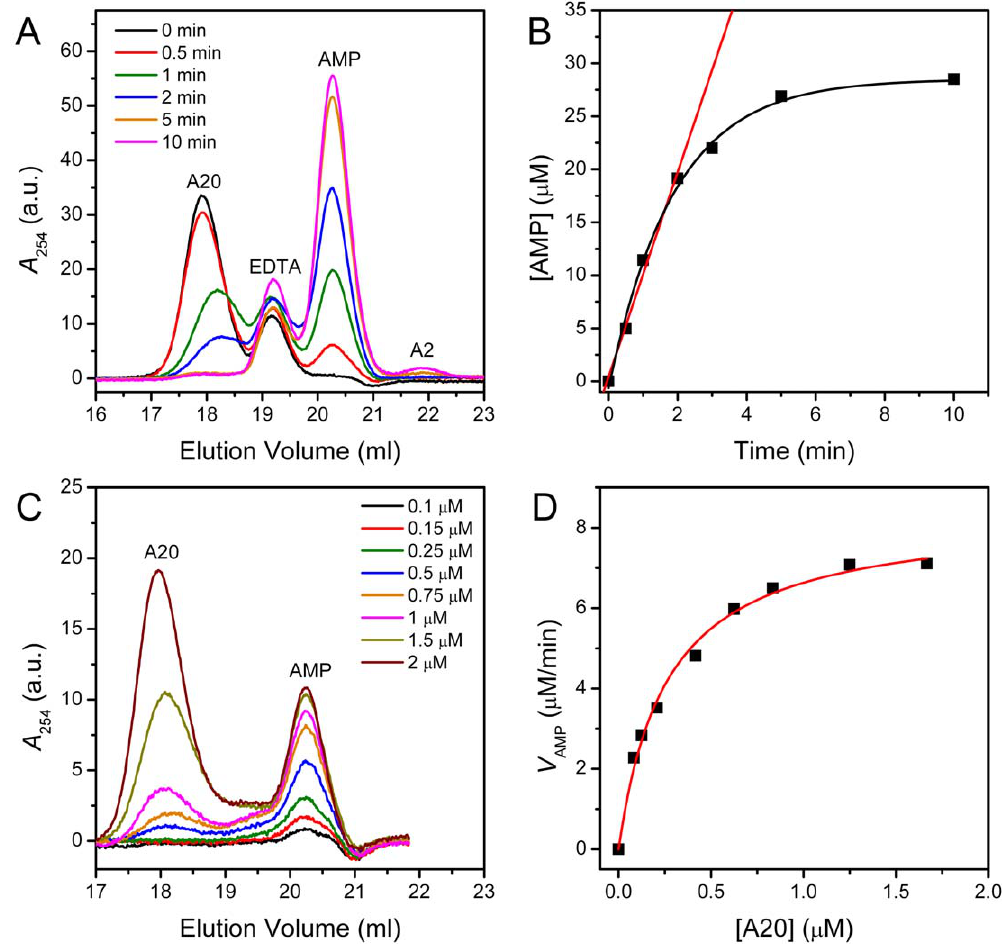
Figure 2. SEC assay of PARN using A20 as the substrate. (A) The elution profiles of the reaction solutions quenched at different time. The initial A20 concentration was 2 m M, and the concentration of PARN was 0.001 mg/ml. The reaction was initiated by mixing 20 m l enzyme and 100 m l substrate. After incubated at 37 u C for a given time, the samples were cooled on ice. EDTA was added to the samples to terminate the reaction, and then the samples were injected into the SEC column. (B) Time-course changes of the AMP during reaction. The concentration of AMP was calculated from the peak area using the standard curve shown in Figure 1C. (C) SEC profiles of the reaction solutions using various concentrations of A20 as the substrate. The A20 concentration was ranged from 0 to 2 m M and the final concentration of PARN was 0.001 mg/ml. The reaction time was 1 min. (D) Determination of the enzymatic parameters using the Michaelis–Menten kinetics. The fitted curve is presented as a solid line.